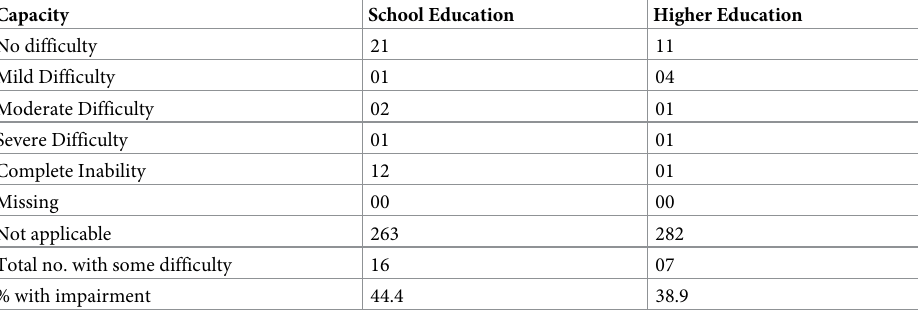
Table 8. Difficulties in attending education.